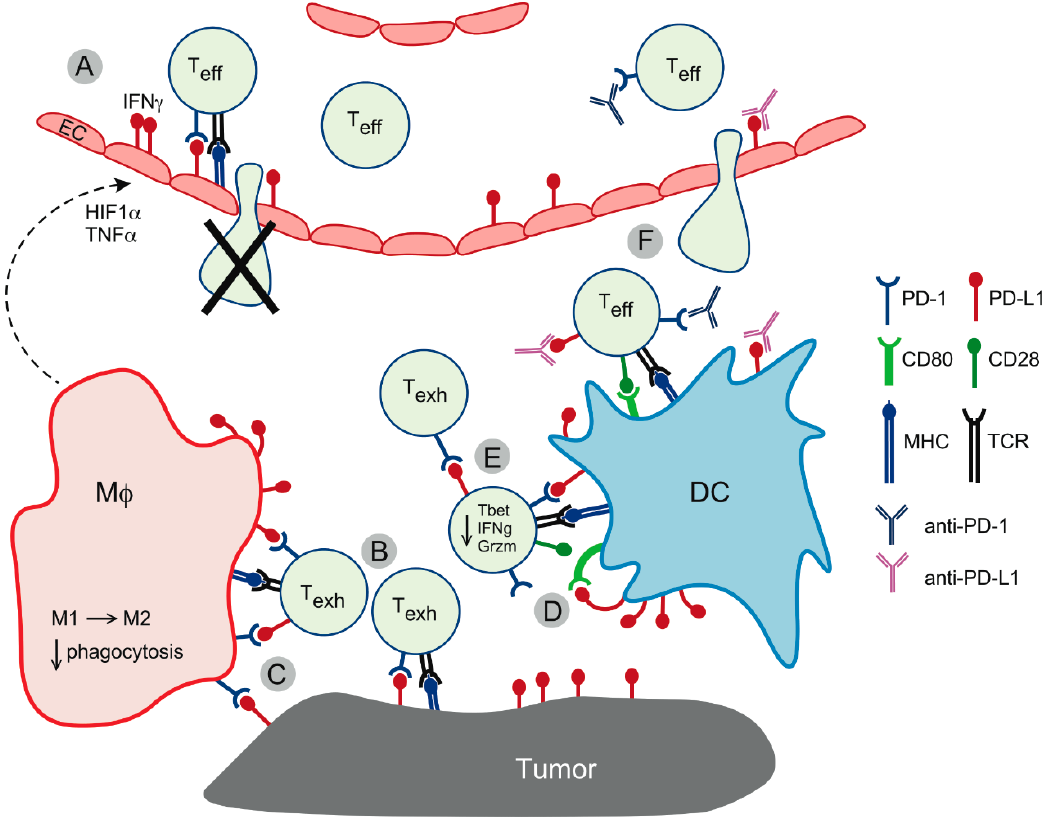
Figure 2. PD-L1-mediated cellular interactions in the tumor microenvironment. ( A ) PD-L1 upregulation on blood vessel endothelial cells (EC) in response to T-cell-derived IFN γ and macrophage-derived hypoxia-inducible factor 1 α (HIF1 α ) and tumor necrosis factor α (TNF α ) functionally inactivates T-cells and reduces their transmigration into the tumor bed. Endothelial cells can also induce Fas-dependent T-cell death in migrating T-cells. ( B ) PD-L1 interacts with PD-1 on T-cells maintaining a state of exhaustion / dysfunction (T exh ). ( C ) PD-L1 expressed on T-cells interacts with PD-1-positive macrophages (M φ ), promoting M2 polarization and functional impairment. ( D ) PD-L1 on dendritic cells (DC) sequesters CD80 in cis , preventing it from interacting with CD28 on T-cells and thus abolishing T-cell activation. Excess of PD-L1 binds PD-1, contributing to T-cell exhaustion. ( E ) Reverse signaling via PD-L1 on T-cells impairs effector functions, such as cytokine production and killing capacity, while at the same time protecting T-cells from death, thus contributing to the expansion of functionally impaired T-cell clones. ( F ) Therapeutic antibodies restore T-cell effector function (Teff) by blocking PD-1 and / or PD-L1 signaling to the T-cell and releasing PD-L1-bound CD80 for interaction with CD28, thus enhancing T-cell stimulation upon antigen recognition via the T-cell receptor (TCR). In addition, therapeutic antibodies improve T-cell recruitment to the tumor by blocking PD-L1 on endothelial